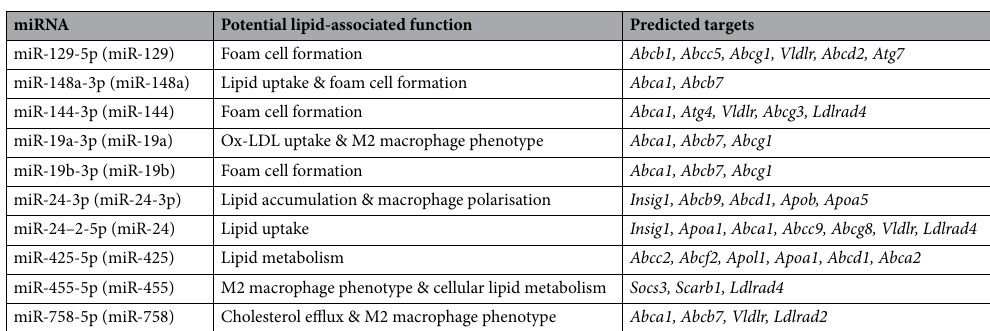
Table 1. miRNA chosen for profiling in MAP infected macrophages.